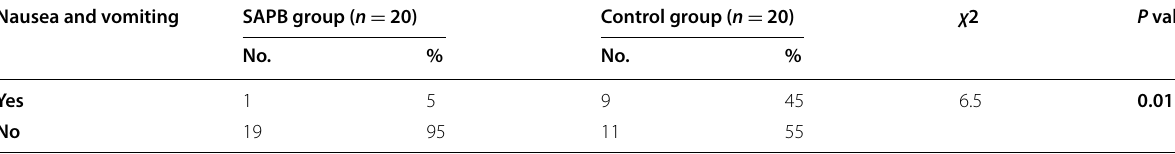
The data expressed as percentage, χ 2 Chi square